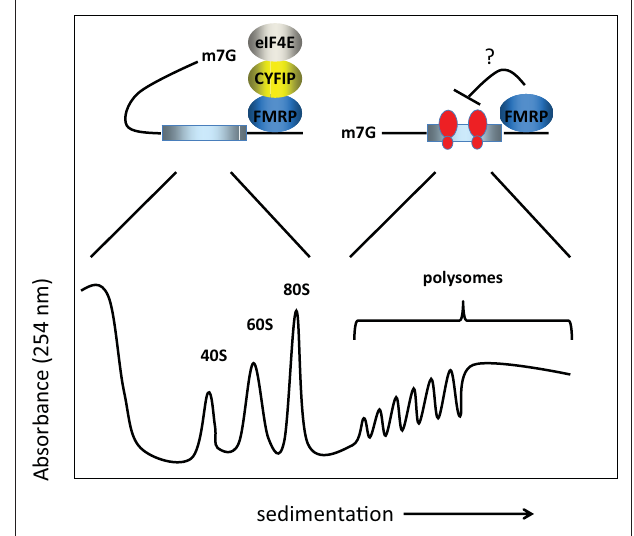
FIGURE 1 | Model for FMRP activity. FMRP has been reported to sediment in both the RNP fractions (i.e., less the 80S monosome) as well as with polysomes in sucrose gradients. In the RNP fractions, FMRP is associated with CYFIP1 and the cap binding factor eIF4E. Here, we show that CYFIP1 inhibits translational initiation by binding initiation factor eIF4E and preventing assembly of eIF4E with eIF4G. In the polysome fractions, FMRP may inhibit protein synthesis by inhibiting polypeptide elongation (i.e., by retarding the rate at which ribosomes move along the mRNA). Thus, FMRP may inhibit translation at two distinct steps, initiation and elongation. 40S and 60S are the ribosomal subunits, 80S is the monosome or complex of the two subunits, and m7G is the cap, a modifi ed nucleotide containing a methyl tag, present at the 5 ′ end of the